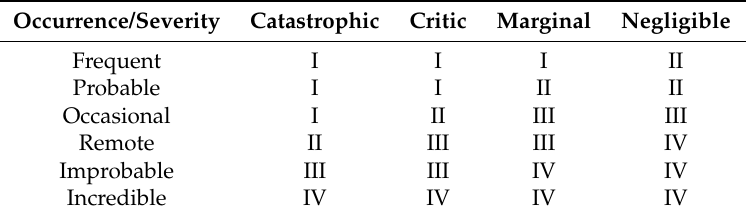
Table 1. IEC61508 risk class